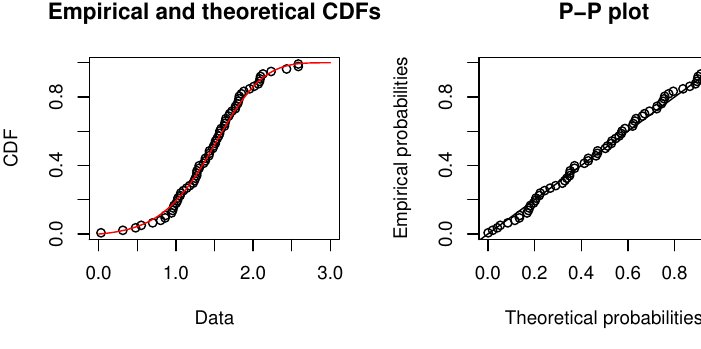
Figure 2. PP, QQ, epdf and ecdf plots of the MBGz distribution for Dataset